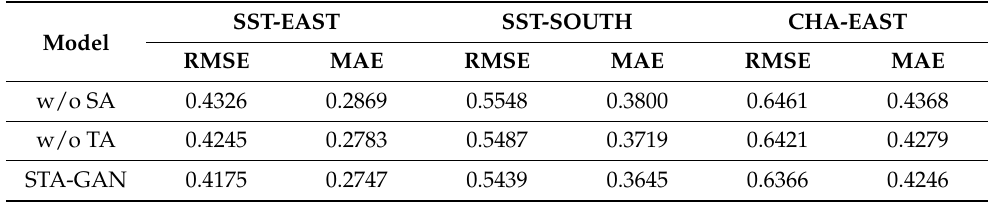
Table 4. The results of the ablation